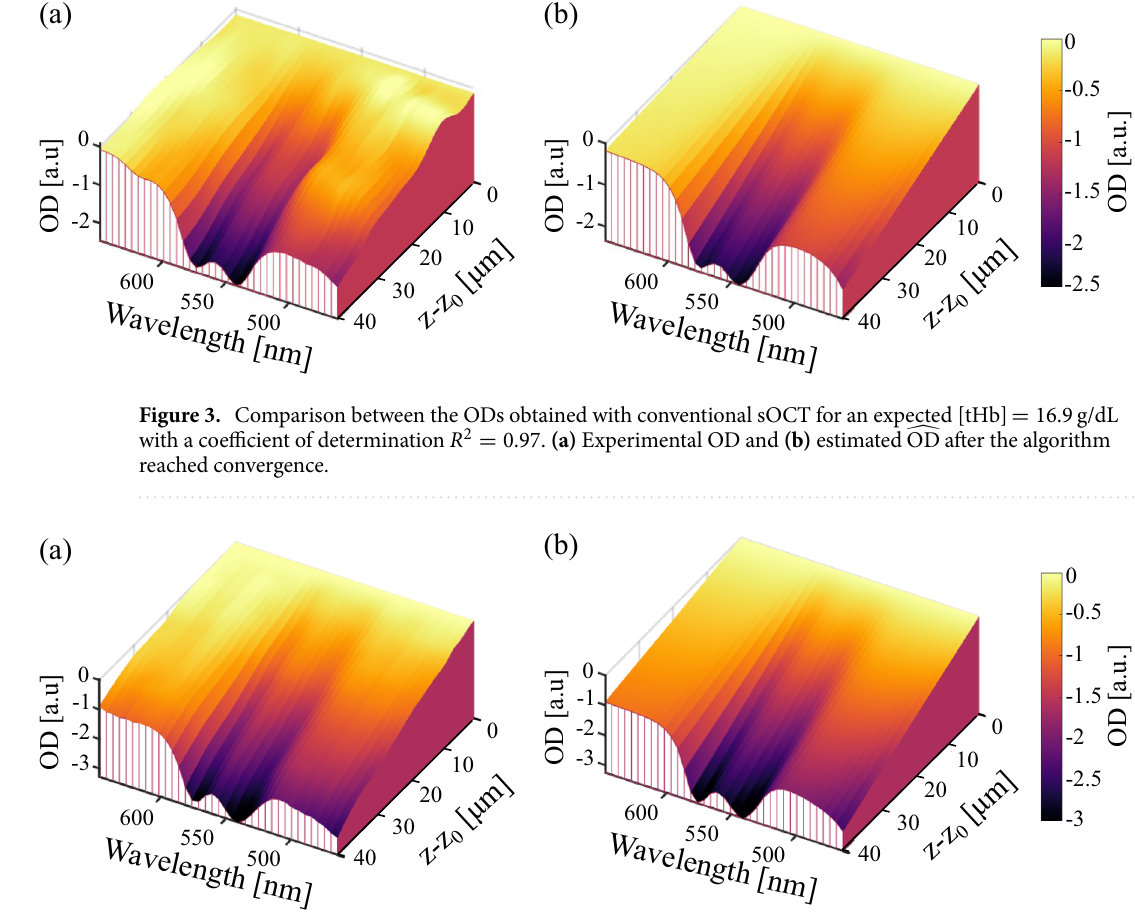
Figure 4. Estimation of the ODs achieved by FZA for an expected [tHb] = 16.9 g/dL with a coefficient of OD after the algorithm reached determination R 2 = 0.98 . (a) Experimental OD and (b) estimated (cid:31) coefficient of determination R 2 = 0.97 for a sample with an expected [tHb] of 16.9 g/dL. After the 51 measure- ments were processed, we obtained an average coefficient of determination with ± SD, R 2 = 0.79 ± 0.25 .